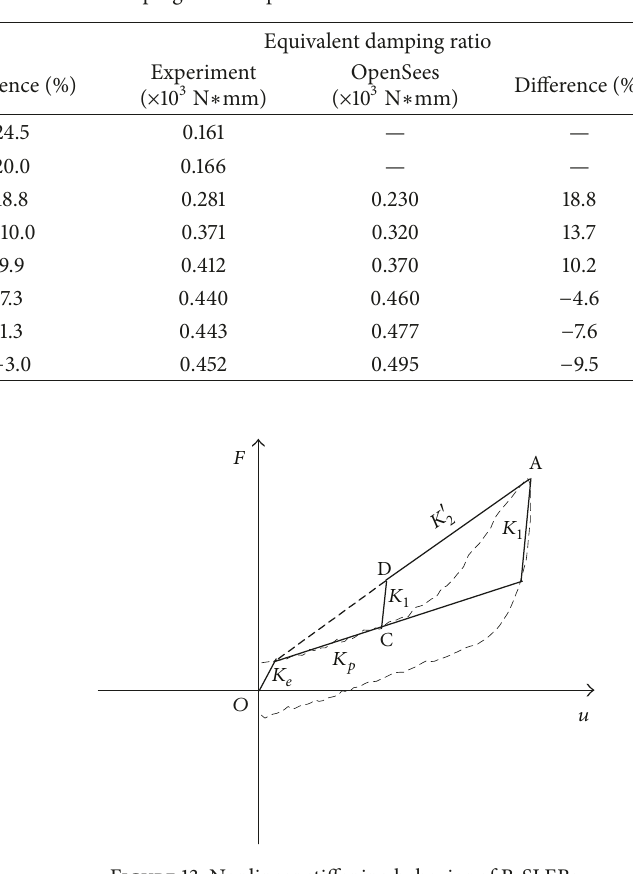
Figure 13: Nonlinear stiffening behavior of B-SLEBs.